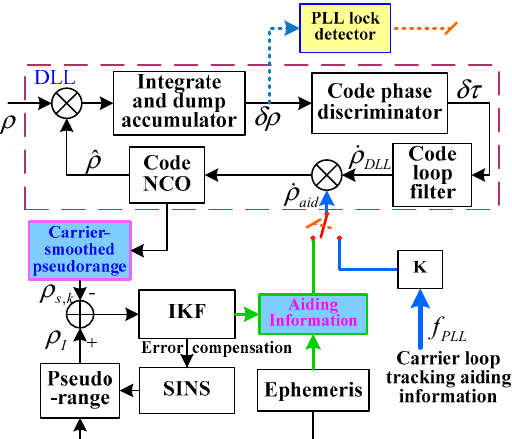
Figure 6. Model of TDCP velocity-assisted DLL tracking. Where ρ I is the pseudo-range calculated by SINS, ρ s , k is the carrier phase measurement smoothed pseudo-range, ρ is the pseudo-range measured by GPS, ˆ ρ is the pseudo-range estimated by the receiver loop, δρ is the pseudo-range error between the GPS measurement and receiver loop estimation, f PLL is the carrier loop tracking aiding frequency, δτ is . ρ the phase di ff erence of the receiver pseudo-random code, is the pseudo-range rate calculated by DLL . ρ the receiver loop, and is the pseudo-range rate for aiding aid